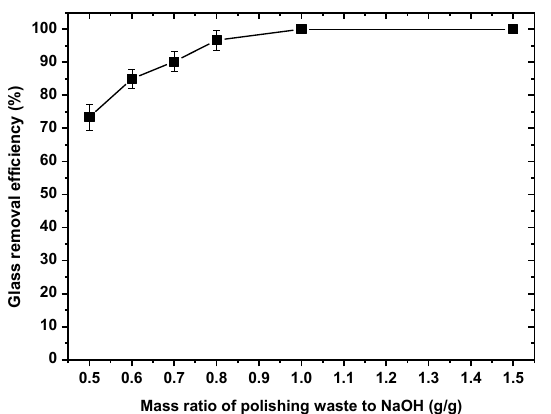
Figure 5. Effect of mass ratio of polishing waste to NaOH on glass removal efficiency (experimental conditions: abrasive – glass polishing waste: approximately 1 g; roasting temperature: 450 °C; roasting time: 2 h; water leaching pH: 3; leaching temperature: 25 °C, liquid – solid ratio: 200 mL/g).